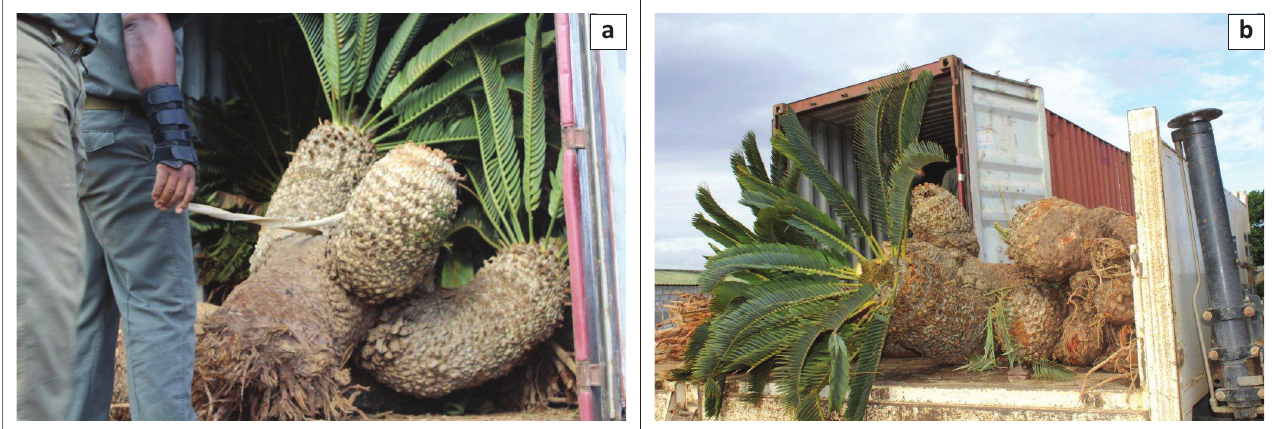
FIGURE 1: Cycad plants recovered from poachers. (a) and (b) E. longifolius